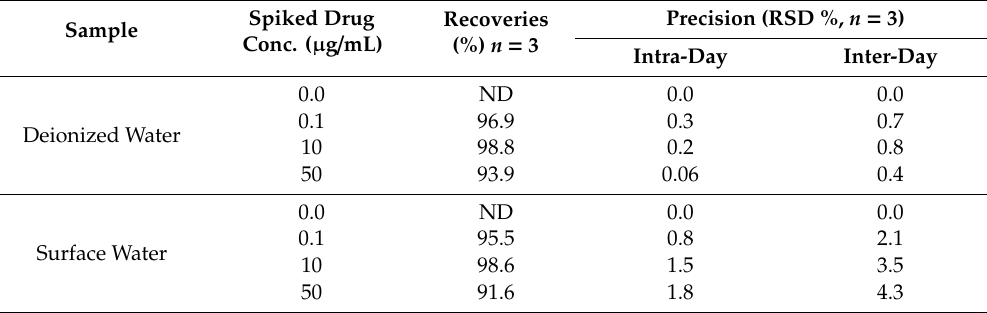
Table 1. Recovery and precision of griseofulvin (GSF) in deionized and surface water samples.